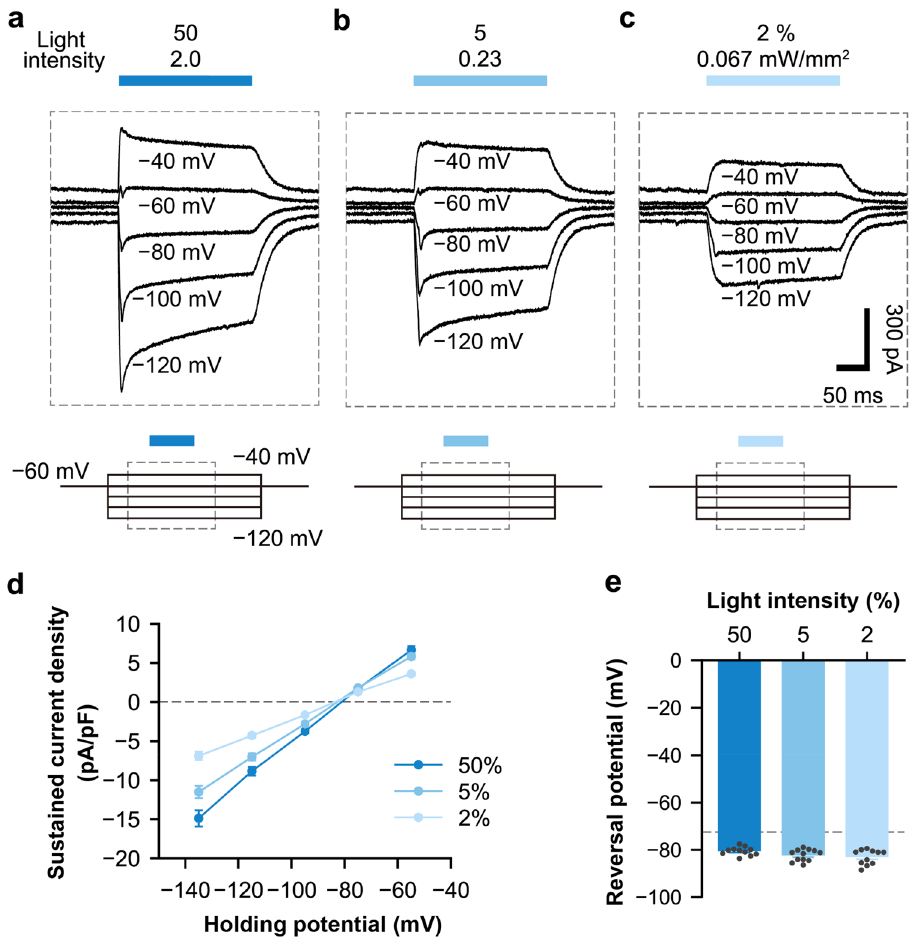
Figure 3. ACR2-induced chloride ion inflow and outflow upon illumination. ( a – c ) Upper: representative traces of photocurrent recording with illumination at different intensities of 470 nm light held at − 120 mV to − 40 mV. Bottom: schematic of the command voltage. The dotted rectangle indicates the timing of the upper traces. Light intensity: 50%, 2.0 mW/mm 2 ( a ); 5%, 0.23 mW/mm 2 ( b ); 2%, 0.067 mW/mm 2 ( c ). ( d ) Sustained current densities as a function of the holding potential. The holding potential was corrected with the junction potential (− 14.9 mV). The dots show mean values ± SEM. Light intensity at 50%, n = 11 cells; 5%, n = 12 cells; 2%, n = 11 cells from 2 animals. The dotted line indicates 0 pA/pF. ( e ) The reversal potential for different light intensities is based on each recording by linear fitting. Bars show the mean values ± SEM. Dots show individual values from each cell. The dotted line indicates the reversal potential of Cl − (− 72.6